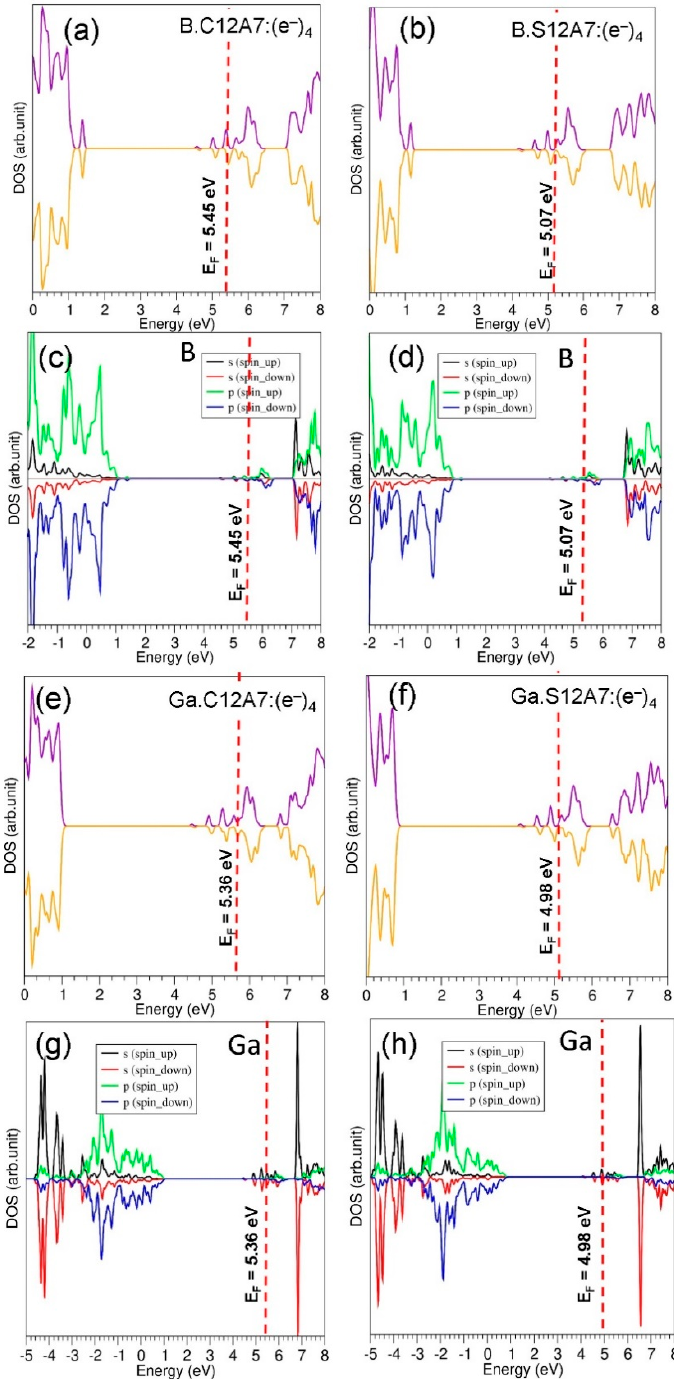
Figure 6. Calculated DOS plots for ( a ) B·C12A7:(e − ) 4 and ( b ) B·S12A7:(e − ) 4 . Corresponding atomic DOS plots calculated for B are shown in ( c ) and ( d ), respectively. Similar DOS plots ( e – h ) are also shown for Ga·C12A7:(e − ) 4 and ( b ) Ga·S12A7:(e − ) 4 .